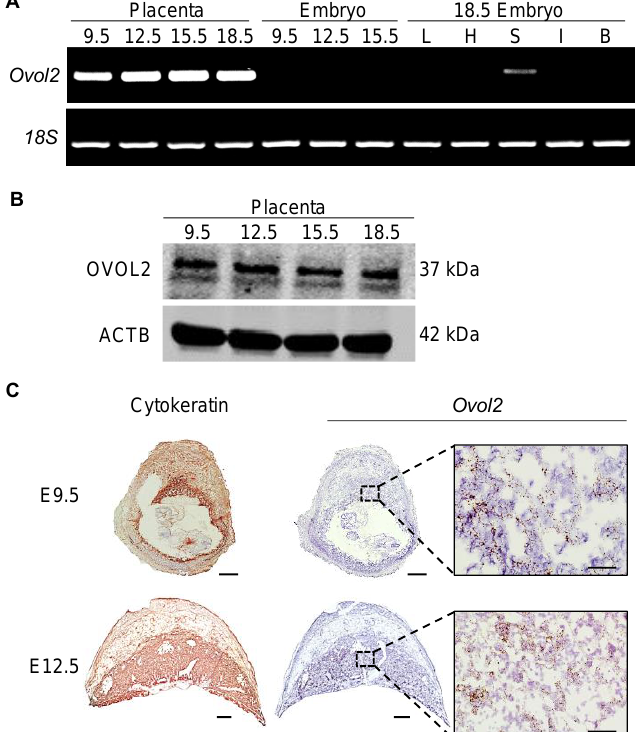
Figure 1. OVOL2 expression in mouse tissue throughout gestation. ( A ) RT-PCR analysis showing expression of Ovol2 and Rn18s ( 18S ) in mouse placenta and embryo on E9.5, 12.5, 15.5, and 18.5. Ovol2 expression in embryonic liver (L), heart (H), skin (S), intestine (I), and brain (B) were also assessed on E18.5. ( B ) Western blot analysis showing protein expression of OVOL2 in mouse placenta at E9.5, 12.5, 15.5, and 18.5. ACTB was used as a loading control. ( C ) In situ hybridization showing Ovol2 transcript localization in mouse placenta at E9.5 and 12.5. Cytokeratin immunohistochemistry was used to delineate the placenta. The dashed boxes in the low magnification images denote the location of the high magnification images. Scale bar = 500 µm for all images except for the high magnification Ovol2 panels, which represent 50 µm.